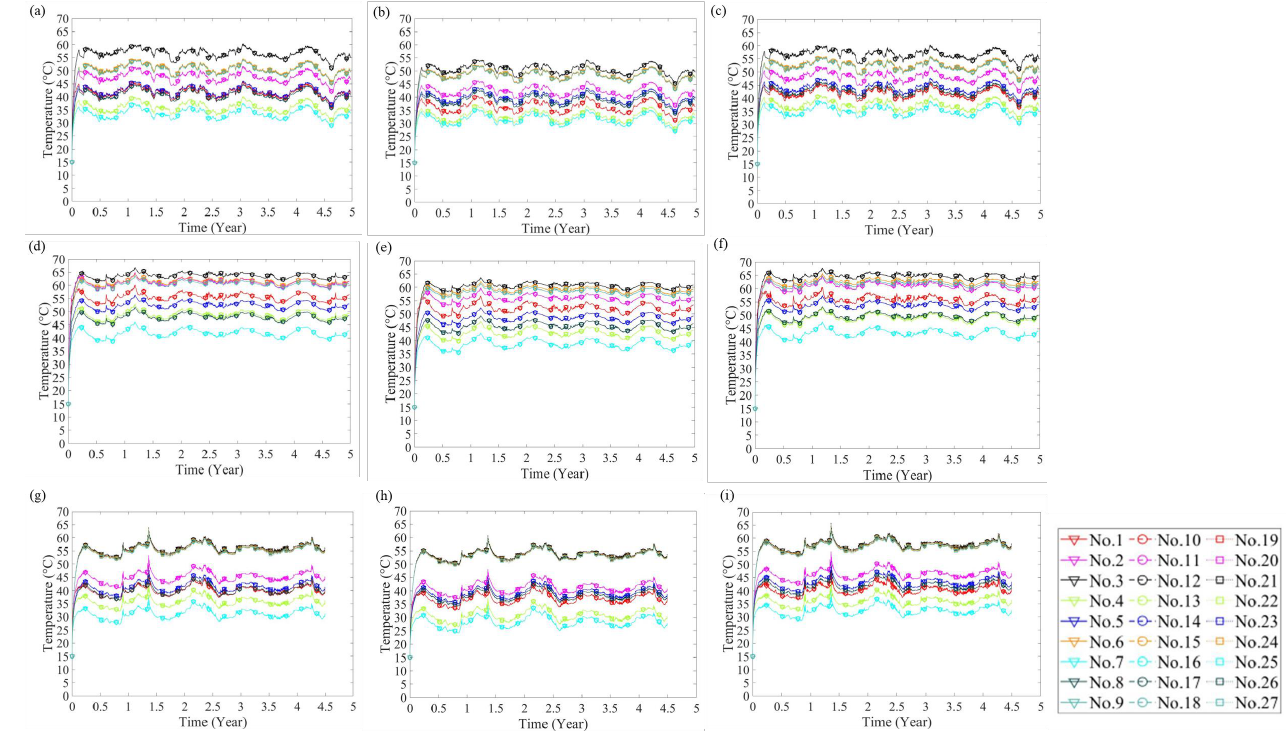
Figure 10. Temperature evolution: backfill of BRU location ( a ) B1 ( b ) LSS ( c ) FSL; LT location ( d ) B1 ( e ) LSS ( f ) FSL; DP location ( g ) B1 ( h ) LSS ( i ) FSL.